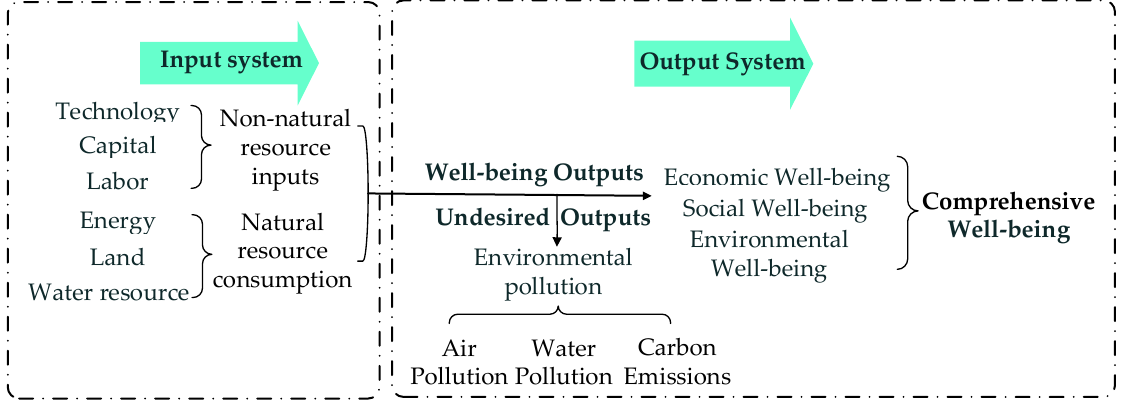
Figure 2. Ecological well-being performance measurement index system in China.